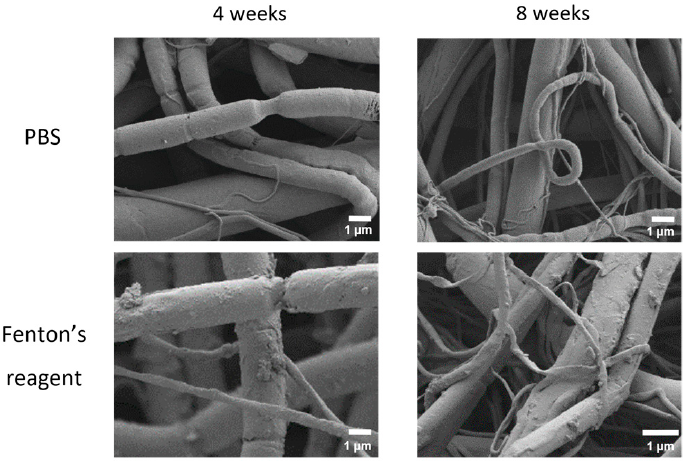
Figure 6. SEM images of electrospun PLA–gelatin (9:1) mats after 4 and 8 weeks of incubation in PBS and in Fenton’s reagent.